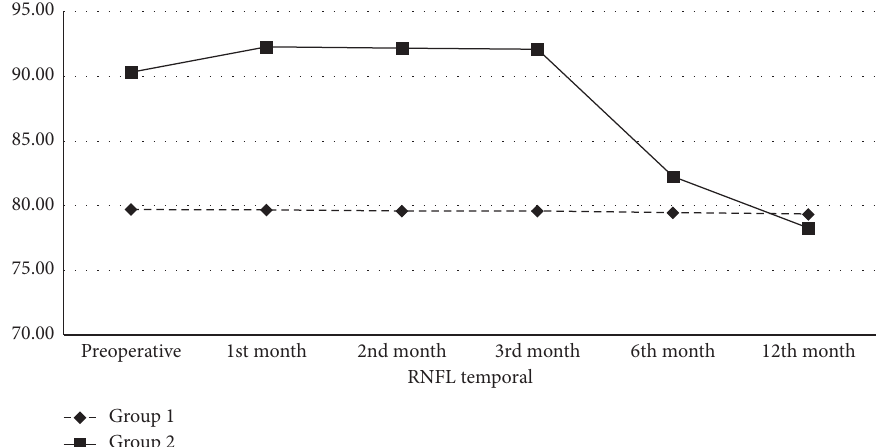
Figure 4: Retinal nerve fiber layer thickness ( μ m) change in the temporal quadrant of the groups. RNFL: retinal nerve fiber layer; μ m: